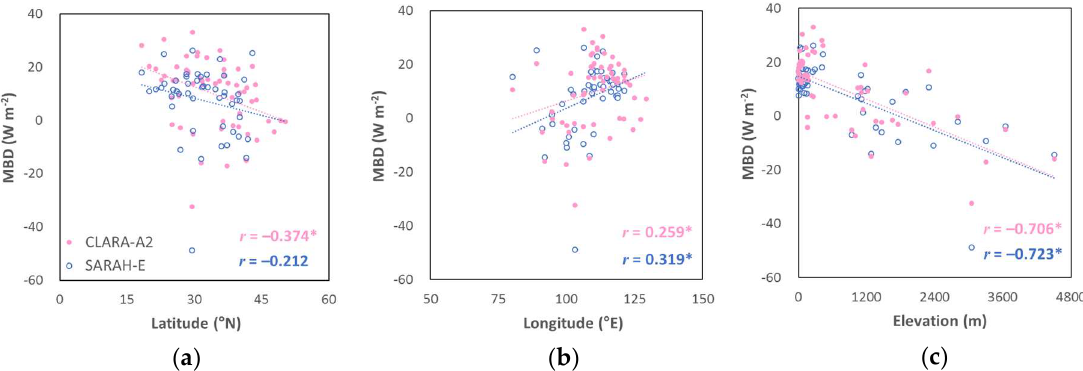
Figure 6. MBD (Mean Bias Deviation, W m −2 ) between satellite-estimated and surface-observed SSR plotted against latitude ( a , °N), longitude ( b , °E) and elevation ( c , m). The pink and blue values are the correlation coefficients 𝑟 for the CLARA-A2 and SARAH-E radiation datasets, respectively; marked with * denotes significant correlation at the 95% confidence level. The number of station samples for the correlation analysis are 59 for CLARA-A2 and 49 for SARAH-E, respectively.